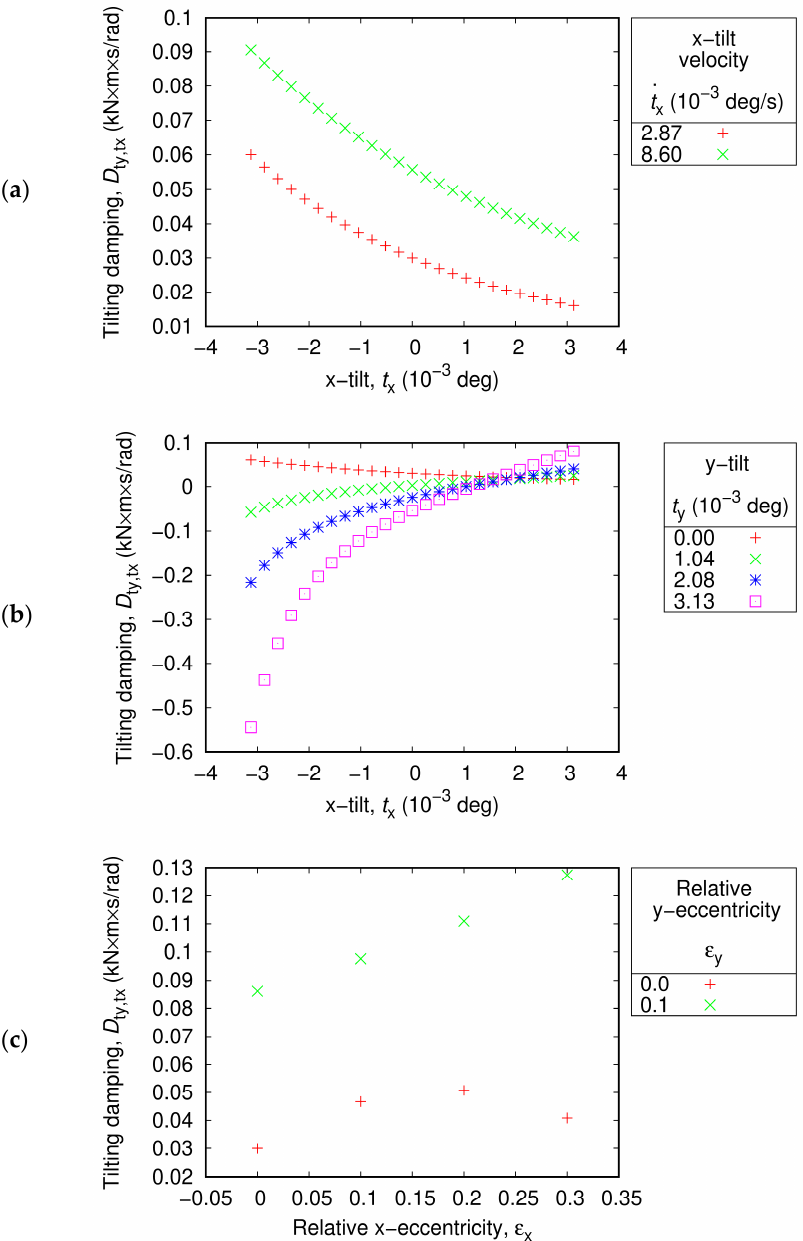
Figure 10. Parameter sensitivity of the cross-coupled damping coefficient D ty , tx : ( a ) Effects of the tilting angle and tilting velocity in the x-direction; ( b ) Effects of x and y tilting angles; ( c ) Effects of relative eccentricities. All unreferenced parameters have zero values.